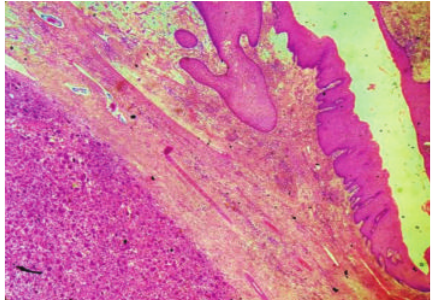
Figure 6: Immunohistochemical staining: showing positivity for endothelial cells to CD34 and negativity for tumor cells.